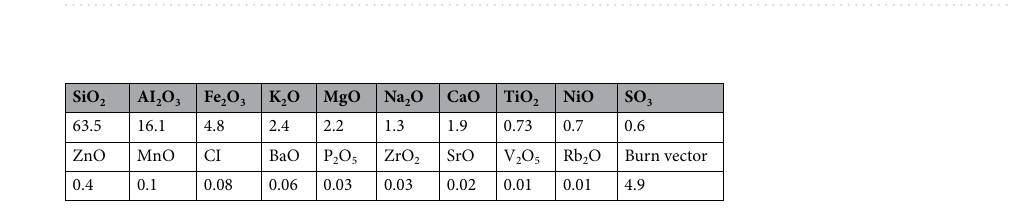
Table 1. Pollutant types and concentrations.